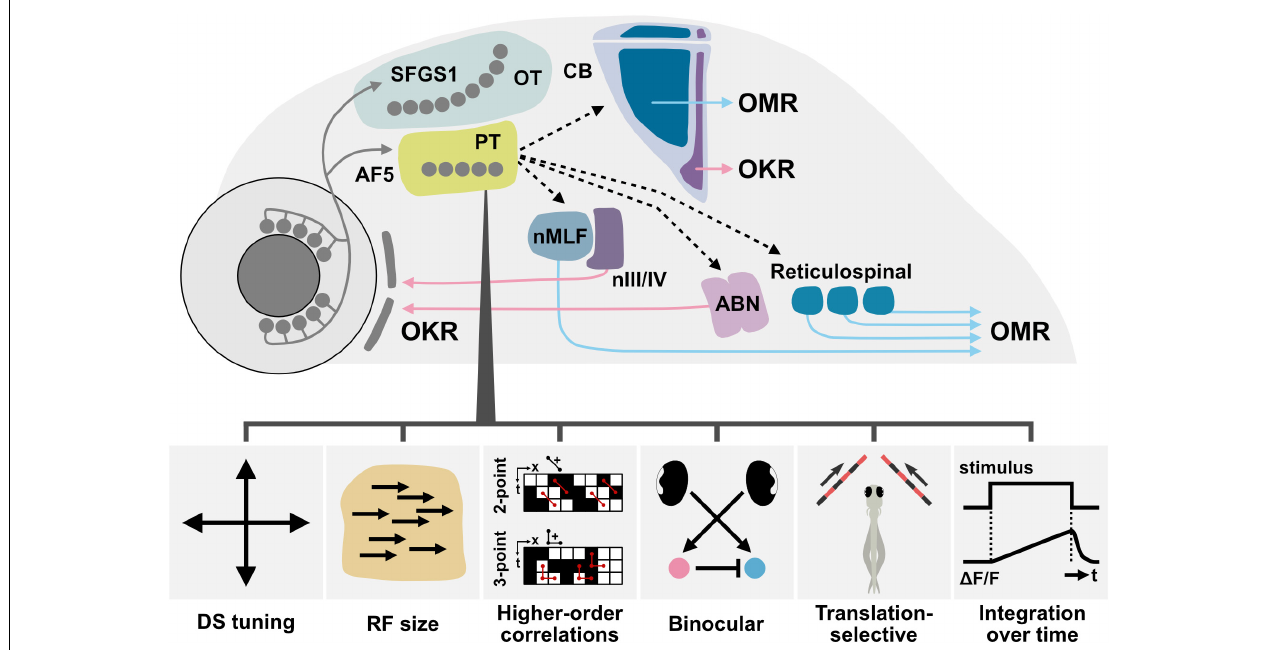
FIGURE 1 | Organization of the optic flow processing circuit in the larval zebrafish brain. The direction selective (DS) retinal ganglion cells (RGCs) project to SFGS1 layer of the optic tectum (OT) neuropil and AF5 in the pretectal (PT) neuropil. DS neurons in the pretectum exhibit various response properties, such as four orthogonally arranged preferred directions, tuning for receptive field (RF) size and location, sensitivity to motion defined by higher-order correlations, binocular integration, translation-selective response, and temporal integration (see section “Pretectum” for details). For triggering OKR, the pretectum sends a signal (either directly or indirectly) to the oculomotor system [the oculomotor (nIII), trochlear (nIV), and abducens (ABN) nuclei] that contains motor neurons controlling the extraocular muscles. OMR swimming is regulated by the midbrain nucleus of medial longitudinal fasciculus (nMLF) and hindbrain neurons including the reticulospinal (RS) neurons, which likely receive visual inputs from the pretectum. nMLF and RS neurons are directly involved in controlling swimming of the fish via their descending axons reaching the spinal cord. In addition, rotation- and translation-selective information is represented in the rostromedial and caudolateral regions in the cerebellum (CB), respectively. OKR, optokinetic response; OMR, optomotor response. Solid lines indicate projections that have been shown in zebrafish larvae, whereas dotted lines represent proposed